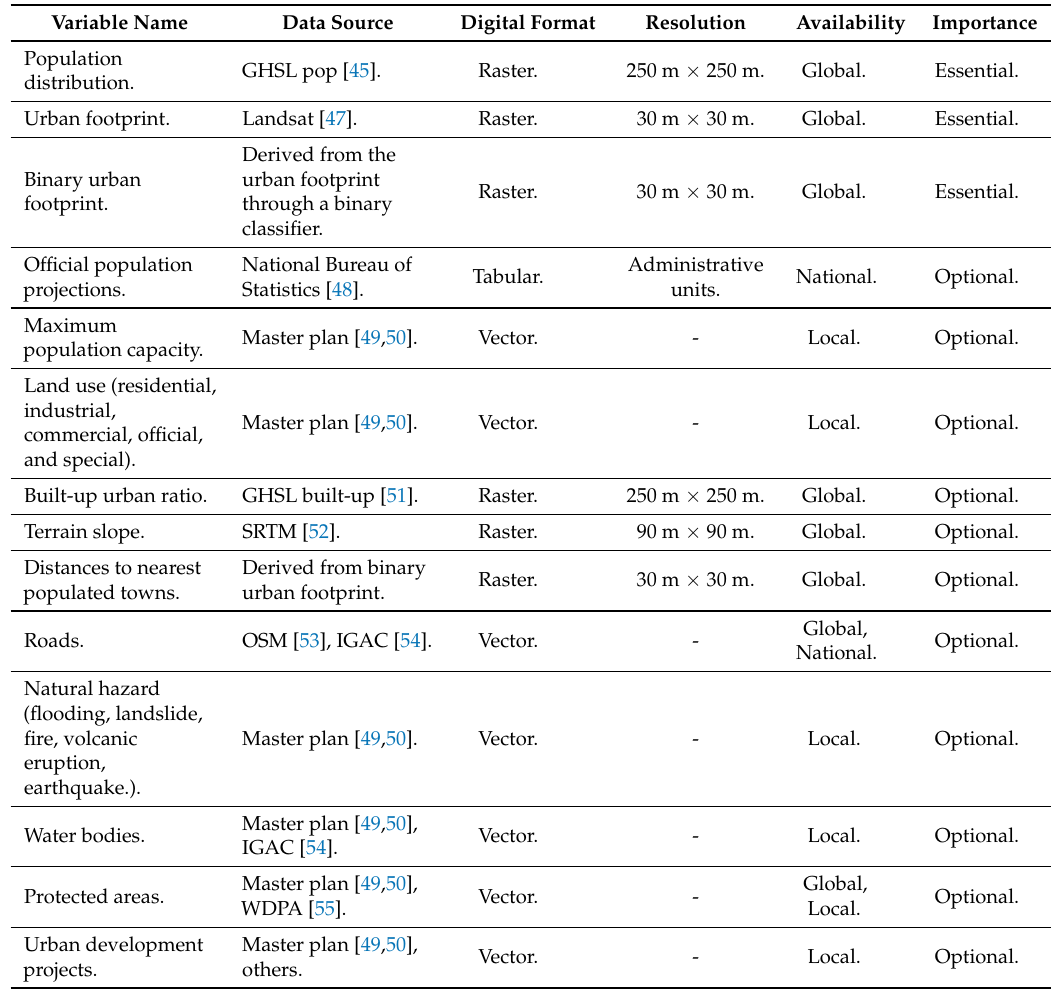
Table 1. Examples of variables that the urban-growth framework can handle. GHSL = Global Human Settlement Layer; SRTM = Shuttle Radar Topography Mission; OSM = Open Street Map; IGAC = Agustín Codazzi Geographic Institute; WDPA = World Database on Protected